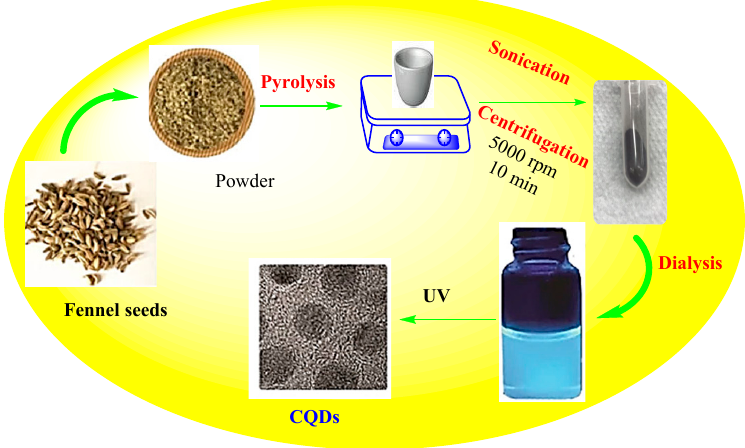
Figure 9. Fennel seeds CQDs by pyrolysis technique.